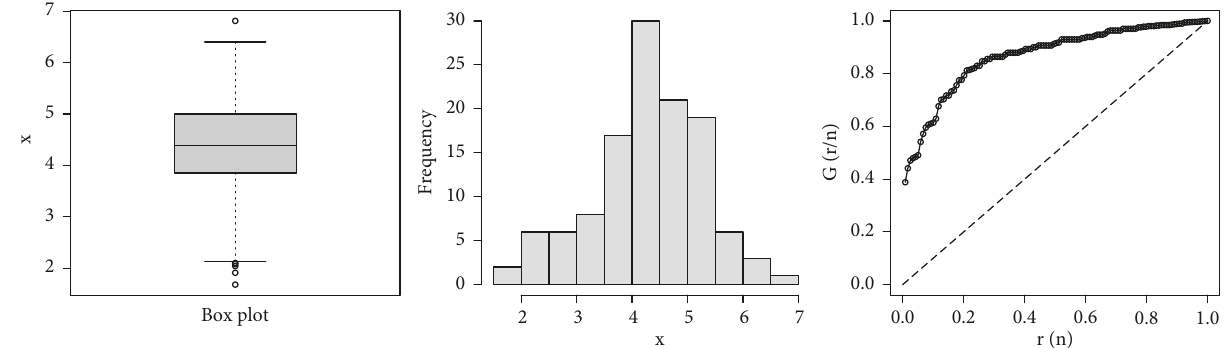
Figure 2: A visual sketching of the Al Table 1: The numerical values of 􏽢 κ , 􏽢 σ , 􏽢 φ , 􏽢 δ , 􏽢 η